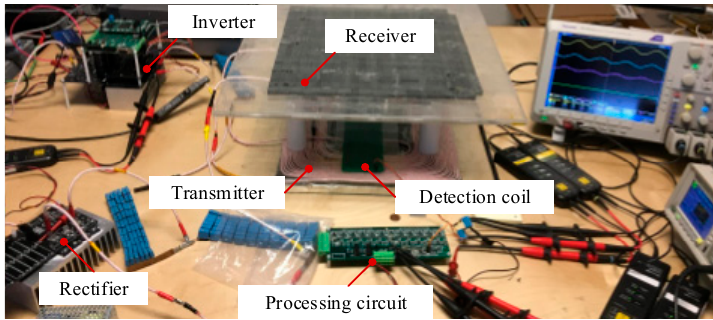
Figure 20. Photograph of wireless electric vehicle (EV) charging system with MOD system. Energies 2020 , 13 , x FOR PEER REVIEW